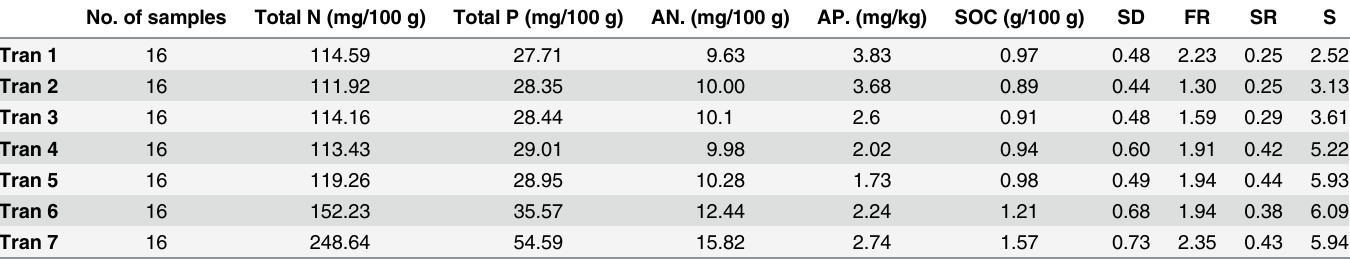
Table 1. Soil fertility indicators (AN — available N; AP — available P; SOC — soil organic carbon), species diversity (SD), species redundancy (SR), functional redundancy (FR), and community stability (S) in seven transects. No. of samples